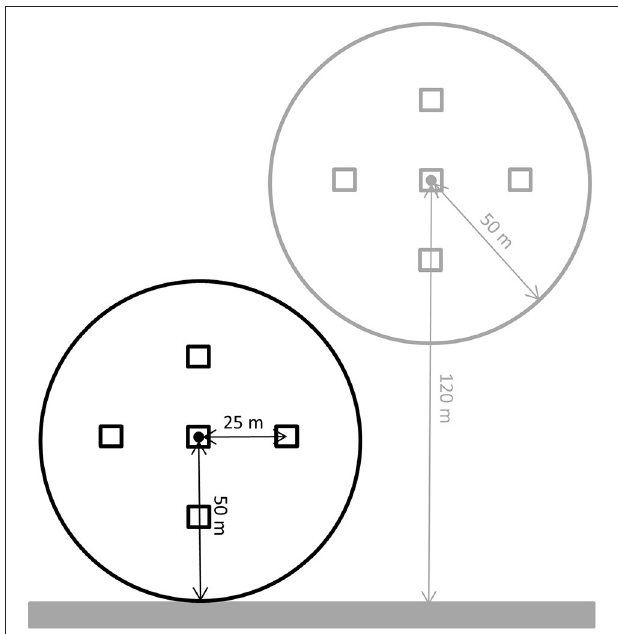
FIGURE 1 | Schematic representation of a pair of points for surveying birds within a radius of 50m (circles). The gray bar represents a trail. The black and gray circles represent the surveyed area of the point close and far from the trail, respectively. Squares (five in each point count circle) show the locations where the vegetation surveys took place. The middle point is the spot from which the bird (point count) survey was